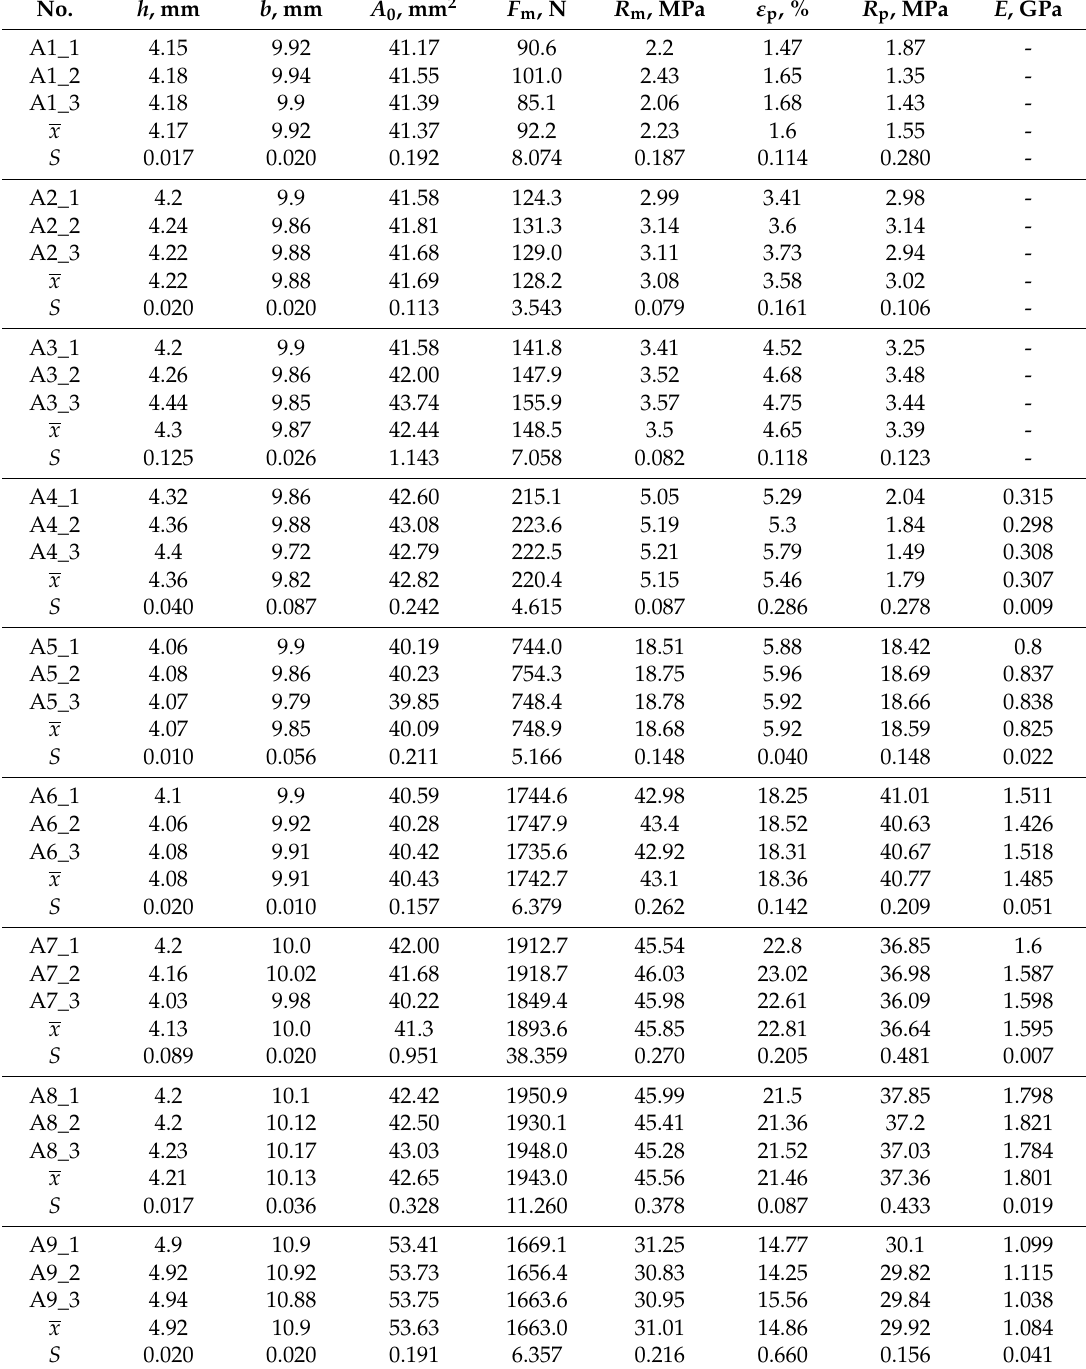
Table 7. Tensile properties with new